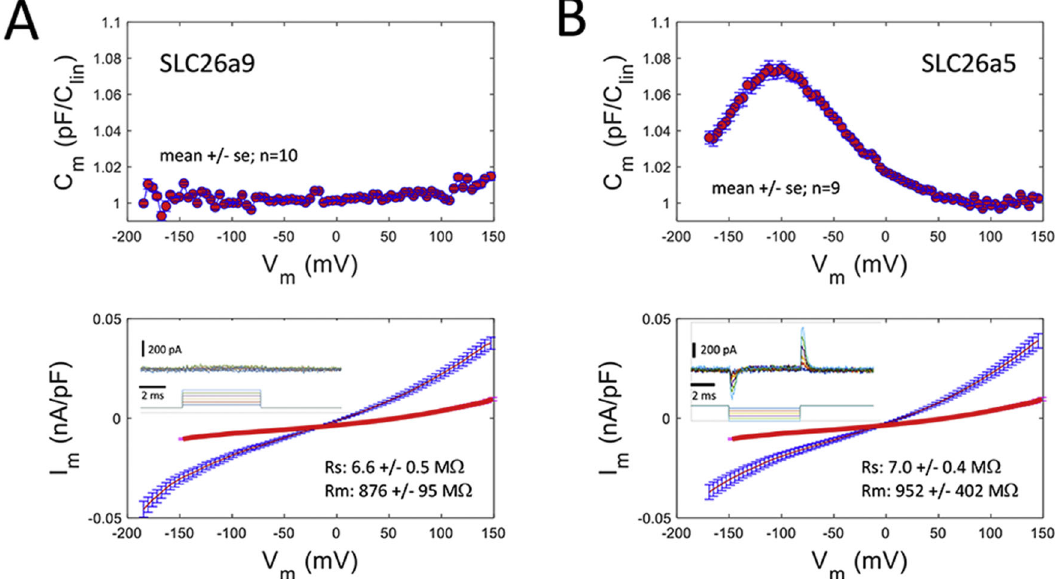
Fig. 4 Slc26a9 is not electromechanical. A Top panel: Capacitance of CHO cells transiently infected with Slc26a9, scaled to linear capacitance near − 100 mV. Measured with dual-sine voltage superimposed on a voltage ramp from − 175 to + 150 mV. A very slight increase in Cm occurs at + 150 mV, possibly indicating an extremely right-shifted NLC. Capacitance data are presented as mean values (± SEM) of 10 independent cells. Inset: Confocal image of CHO cells transfected with Slc26a9-YFP that is expressed on the membrane. The scale bar is 10 microns. Bottom panel: Ramp induced currents simultaneously measured with membrane capacitance, also scaled to linear capacitance. Current data are presented as mean values (± SEM) from the same 10 independent cells shown in the upper panel. Average (± SEM) series and membrane resistance are shown. In red are mean (±SEM) currents observed in untransfected cells ( n = 5). Inset: top traces show very small nonlinear currents extracted with P/ − 5 protocol, subtraction holding potential set to − 50 mV. Voltage protocol shown below traces. B Top panel: Capacitance of CHO cells transiently infected with prestin, scaled to linear capacitance near + 100 mV. Measured with dual-sine voltage superimposed on a voltage ramp from − 175 to + 150 mV. A prominent increase in Cm occurs at − 110 mV, typical of prestin NLC. Capacitance data are presented as mean values (± SEM) of nine independent cells. Bottom panel: Ramp-induced currents simultaneously measured with membrane capacitance, also scaled to linear capacitance. Current data are presented as mean values (± SEM) from the same nine independent cells shown in the upper panel. Average (± SEM) series and membrane resistance are shown. In red are mean (± SEM) currents observed in untransfected cells ( n = 5). Inset: top traces show large nonlinear displacement currents extracted with P/-5 protocol, subtraction holding potential set to + 50 mV. Voltage protocol (holding potential 0 mV) shown below traces. Source data are provided as a Source Data fi